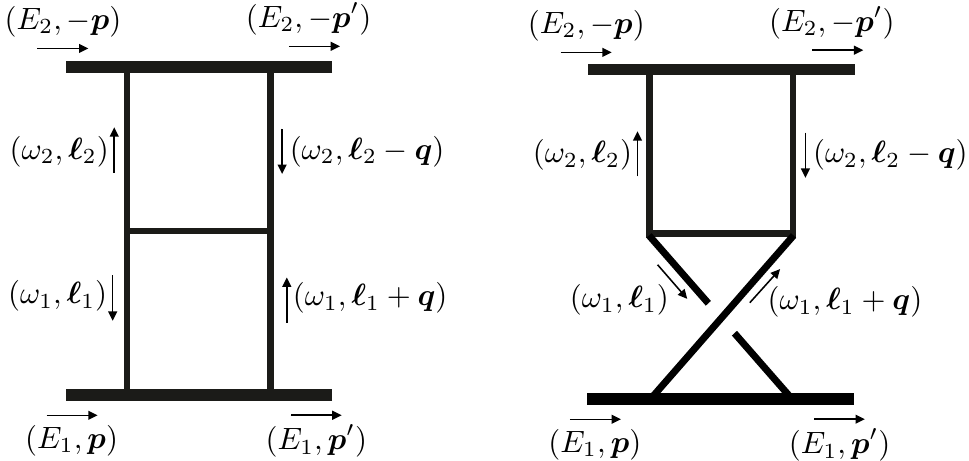
Figure 21 . The H and crossed-H